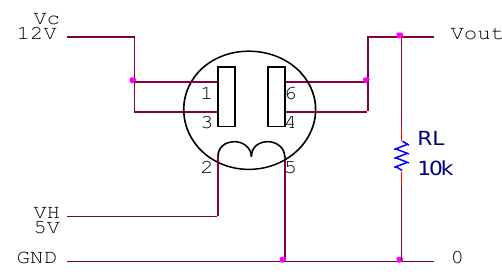
Figure 3. Measuring cicuit for TGS2xxx sensor.